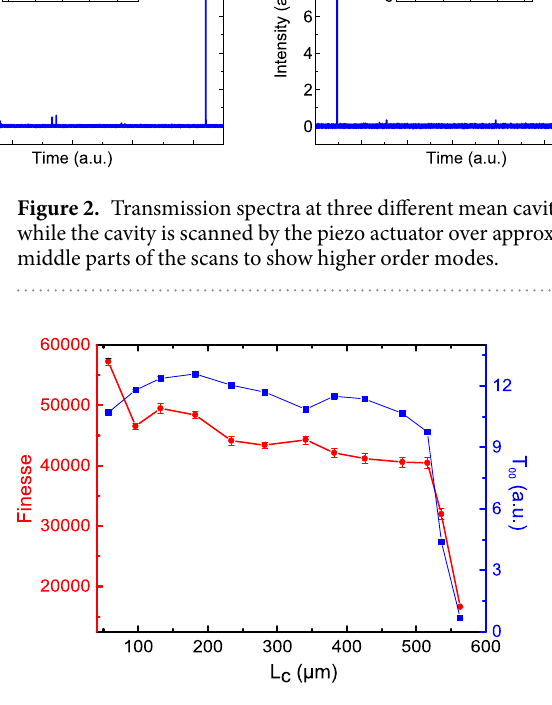
Figure 3. Finesse (circle) and transmission intensities (square), for the fundamental mode, ( T 00 ) as a function of cavity length ( L c ) for the FA-MM configuration described in the text. An average of 20 traces is taken for each data point. The error bars indicate the mean standard errors.